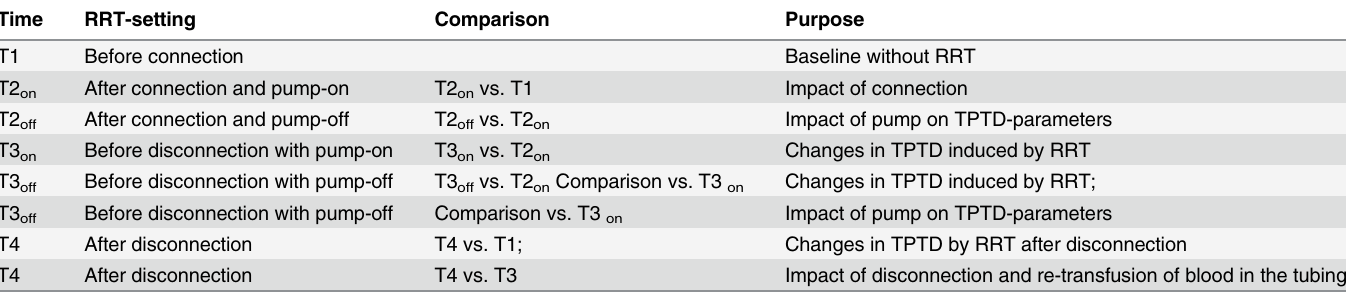
Table 1. Potential experimental